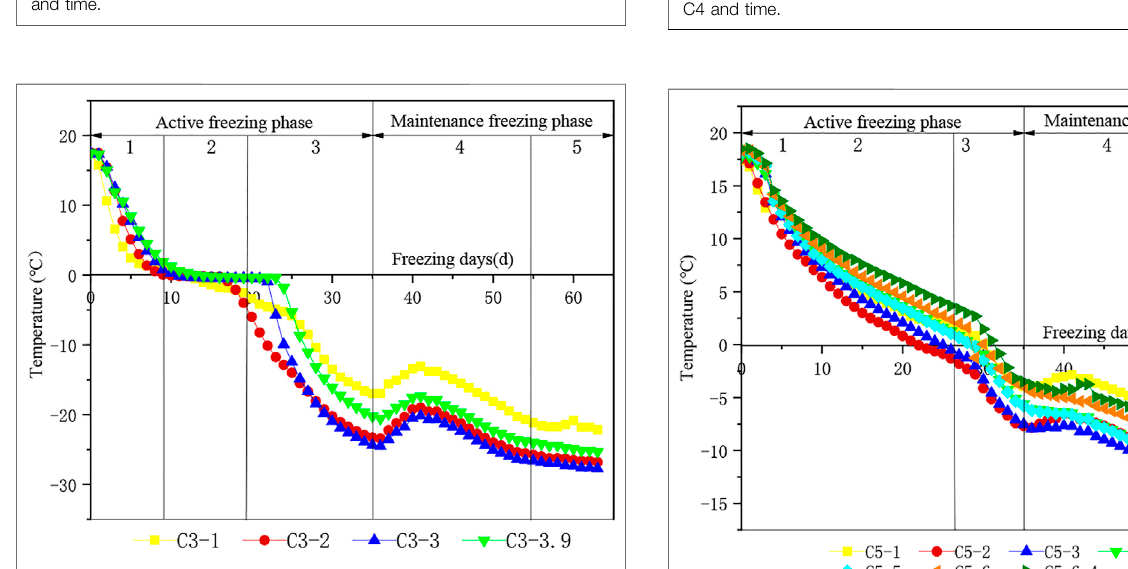
FIGURE 11 | Correlation between the temperature in temperature hole C4 and time.